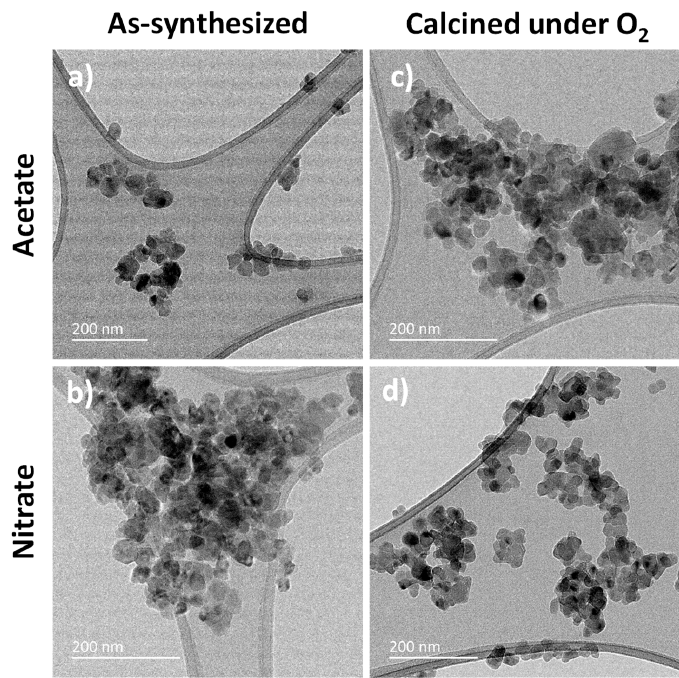
Figure 4. TEM of as-synthesized ( a , b ) and calcined in O 2 ( c , d ) MgF 2 prepared from acetate and nitrate magnesium precursors, after the HF activation step.